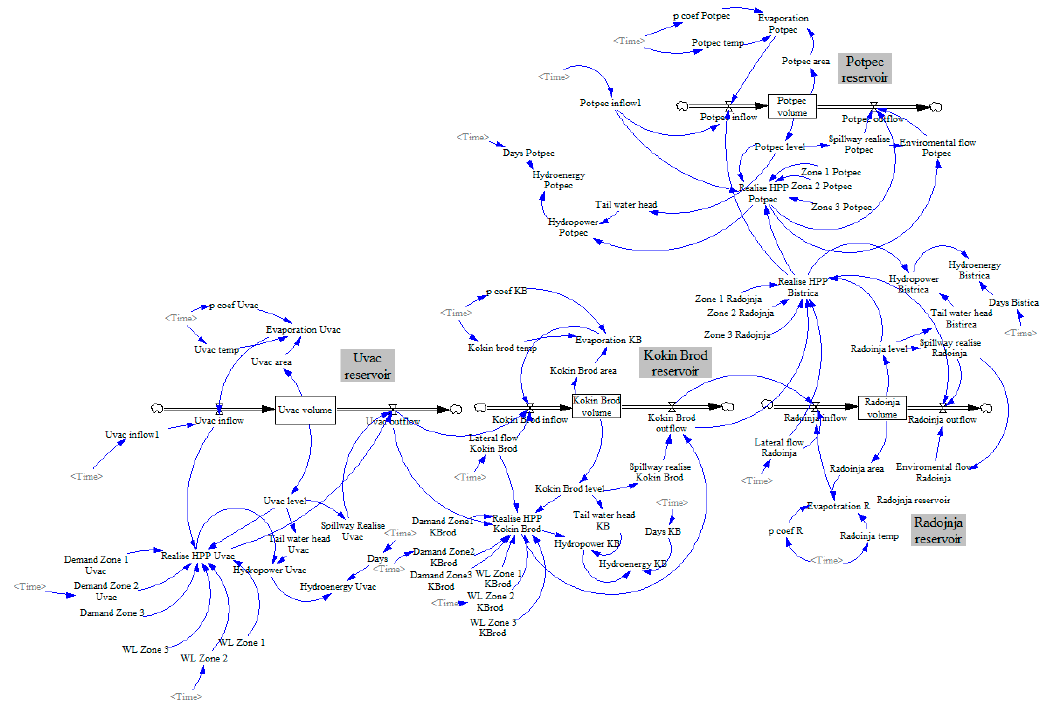
Figure 4. Stock and flow diagram of the Lim water system consisting of four reservoirs (Uvac, Kokin Brod, Radojnja and Potpec).